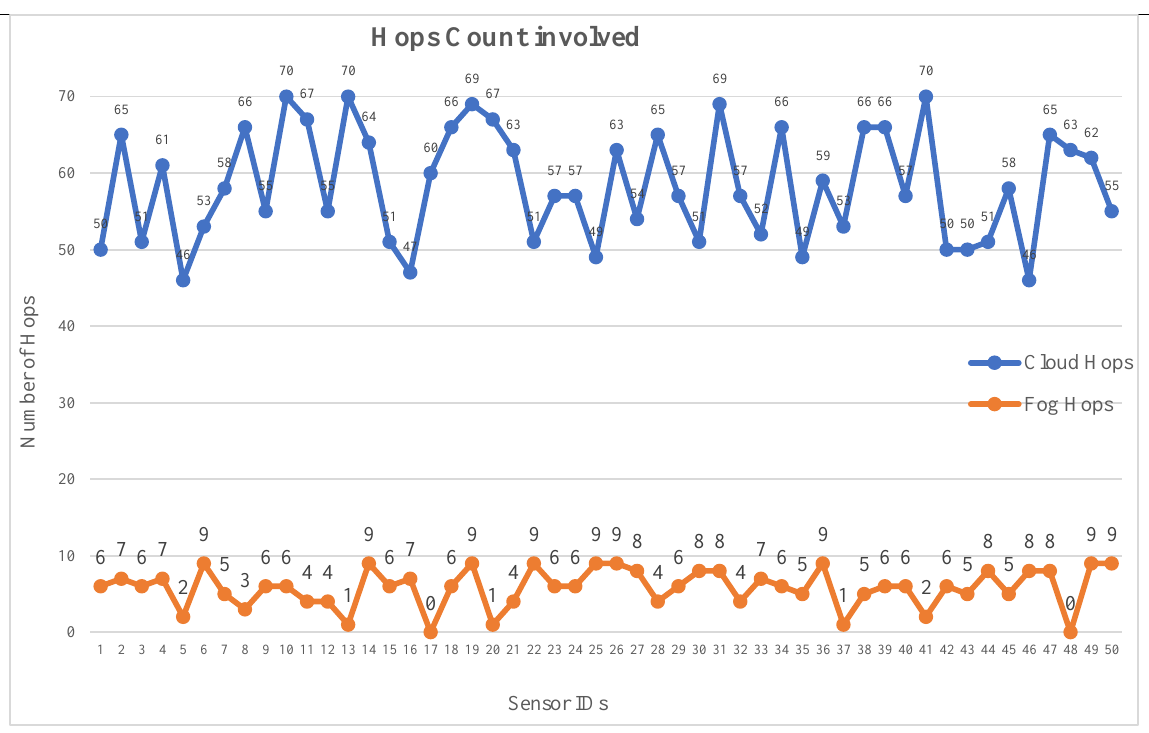
Figure 6. Fog and Cloud Hop Number